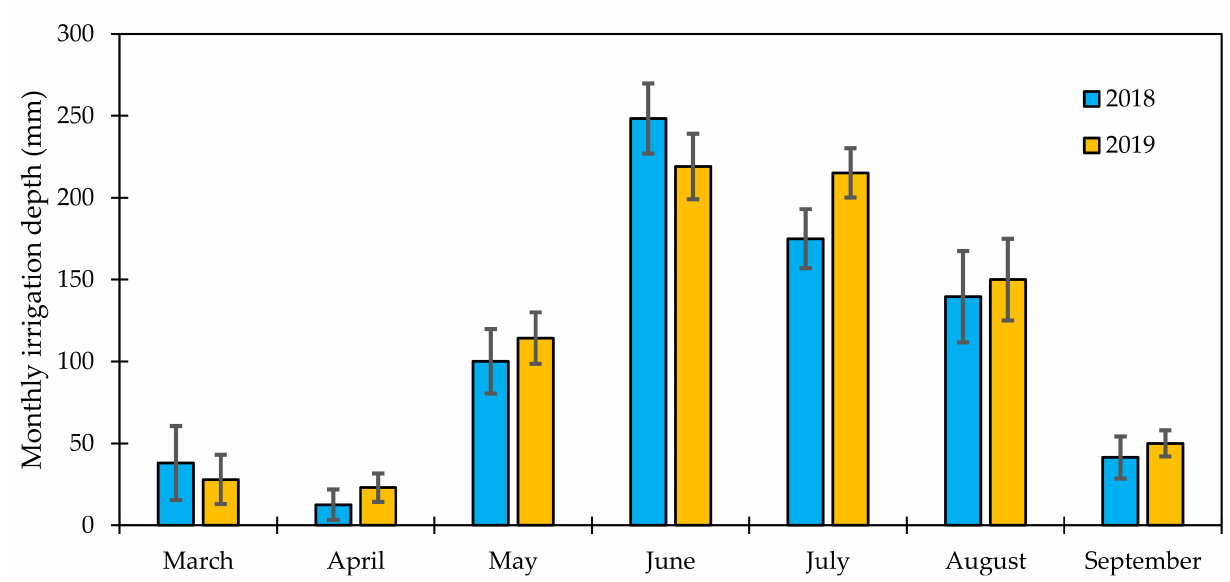
Figure 8. Monthly irrigation amount applied with standard deviation among five fields during the 2018 and four fields during the 2019 potato growing